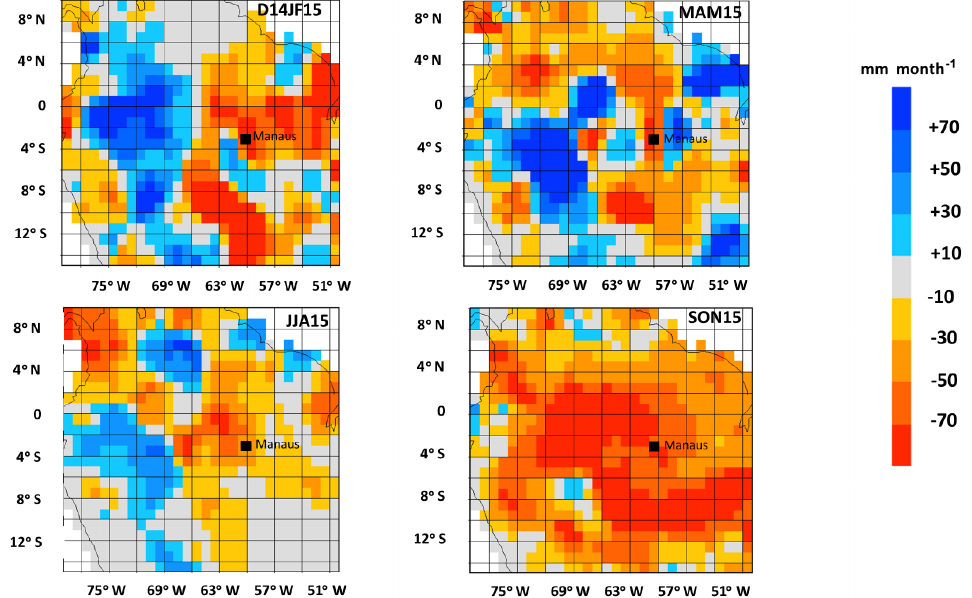
Figure 1. Rainfall anomaly (mmmonth − 1 ) for 3-month periods from December 2014–May 2015 to September–November 2015. Data come from GPCC and anomalies are relative to the 1951–2001 climatology. Black square indicates the location of